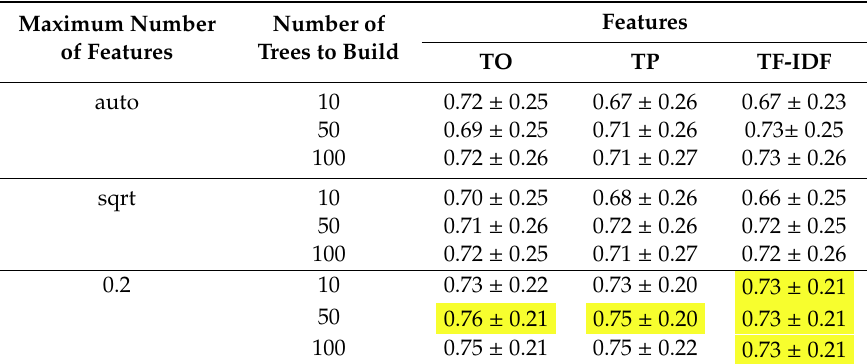
Table 3. Result of parameter tuning for random forest.